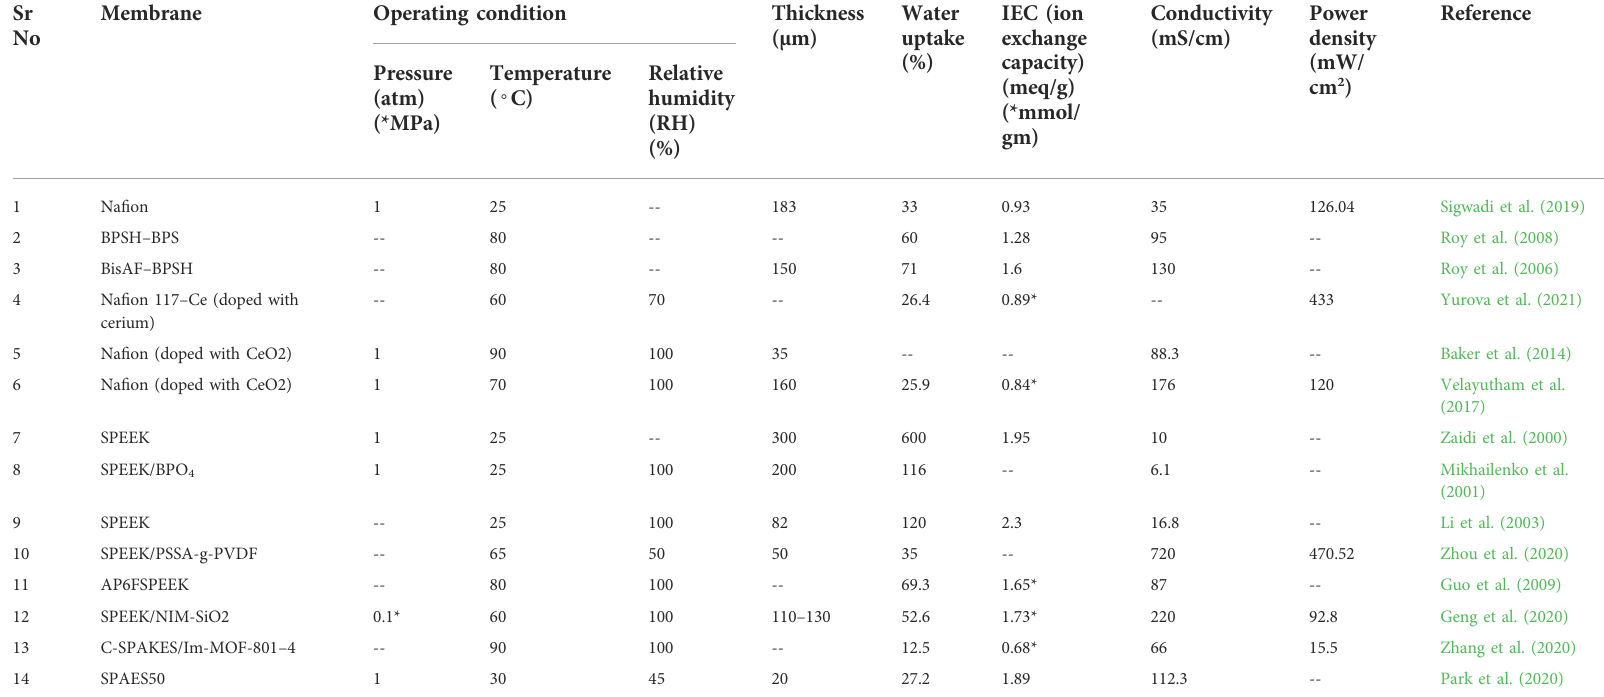
TABLE 2 Comparison of low-temperature PEMs based on thickness, water uptake, IEC, proton conductivity, and power density. Sr